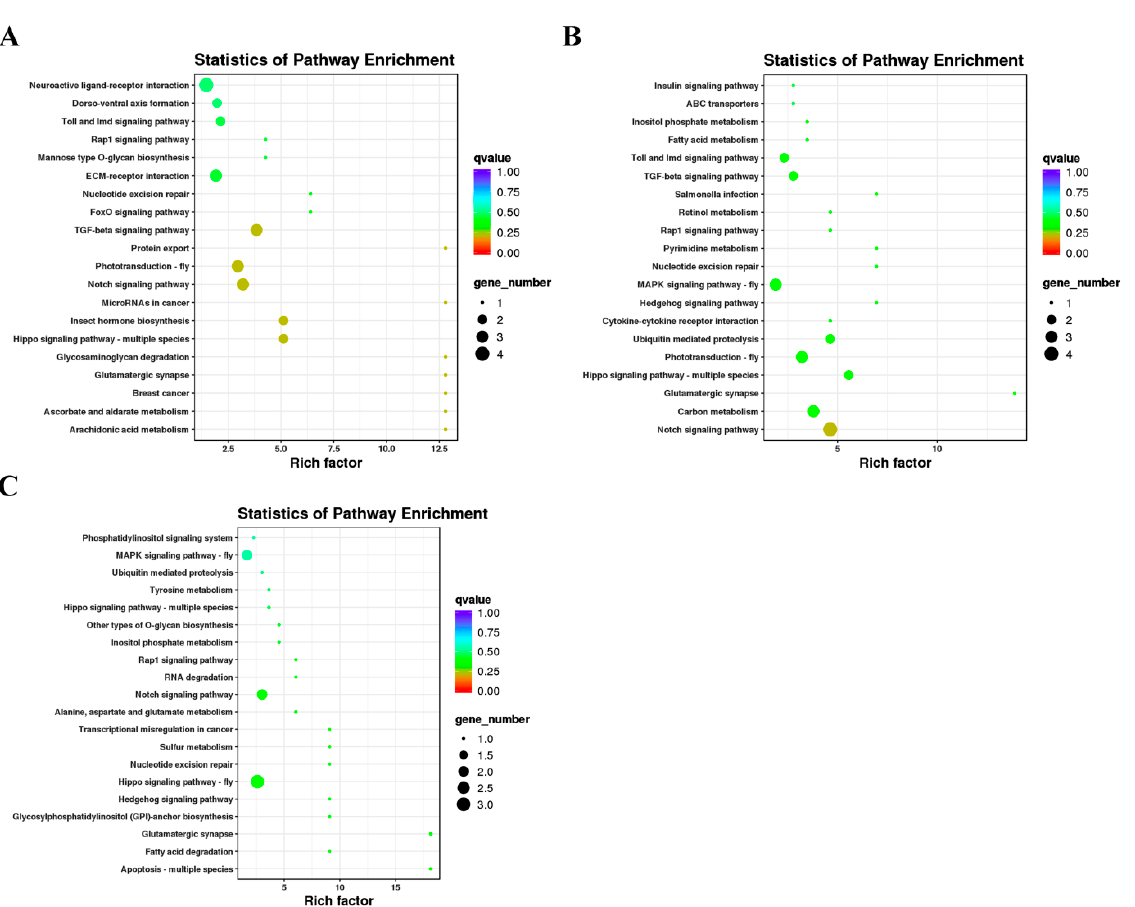
Figure 4. KEGG pathways enrichment analysis of target genes in ( A ) R5d vs. E5d; ( B ) R6d vs. E6d; and ( C ) R7d vs. E7d.